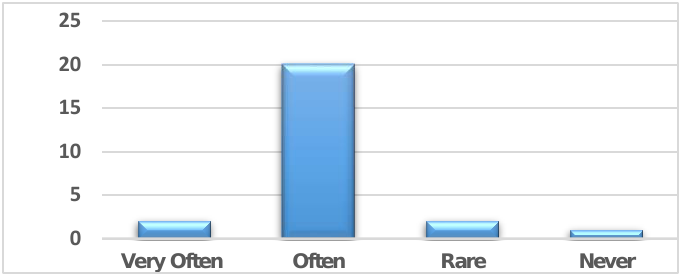
Figure 2. Teachers’ frequency of use of sensors in teaching activities (the number on the Y-axis represents the number of teachers who responded to the focus group posttest questionnaire N =